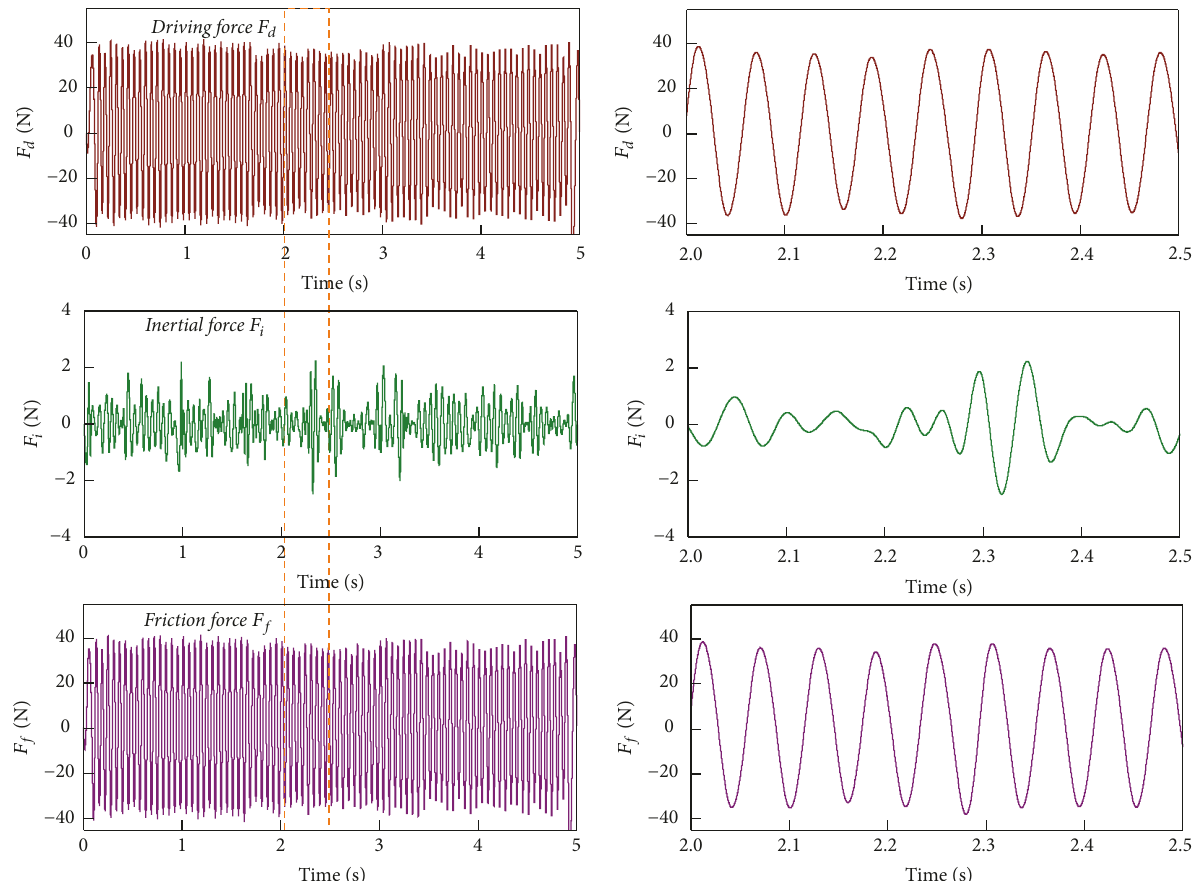
Figure 4: Experimentally determined characteristics of forces 𝐹 𝑑 , 𝐹 𝑖 , and 𝐹 𝑓 during vibrating-sliding friction coupling. Experiment parameters: dry, 𝑢 = 5 mm, 𝑓 = 17Hz, V 𝑑 = 60 mm/s, and 𝐹 𝑁 =